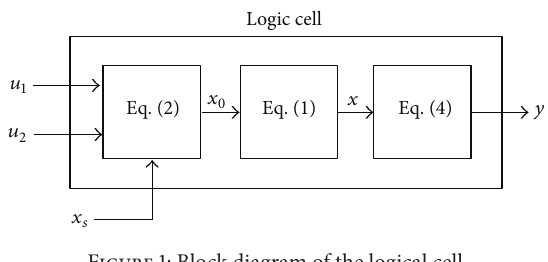
Figure 1: Block diagram of the logical